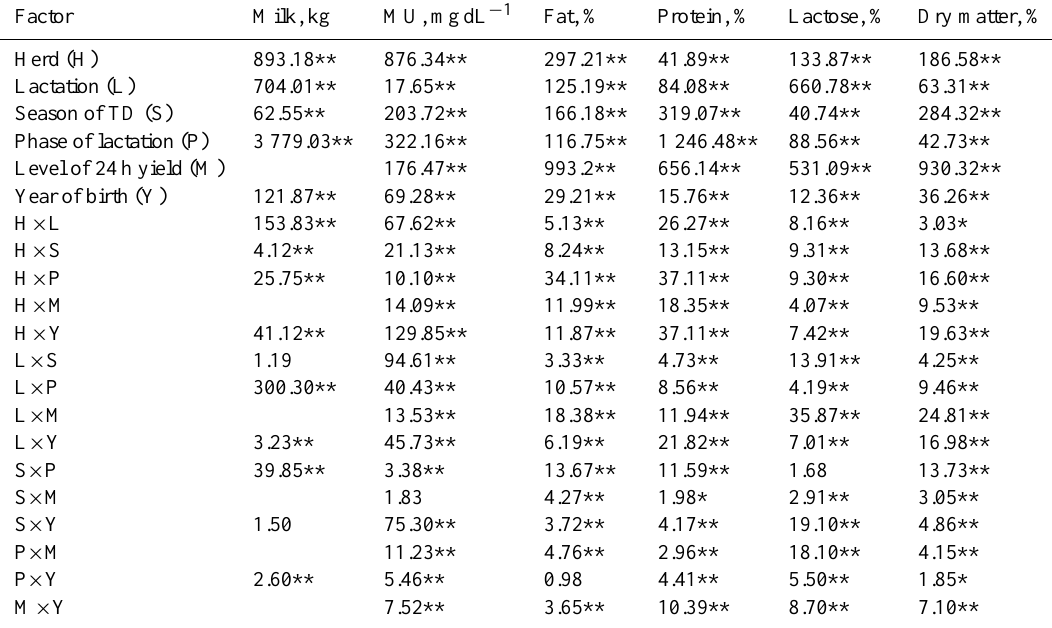
Table 2. The significance of the impact of the tested factors on the level of the urea in cow’s milk. Factor Milk, kg MU, mgdL − 1 Fat, % Protein, % Lactose, % Dry matter, % Herd (H) 893.18** Lactation (L)